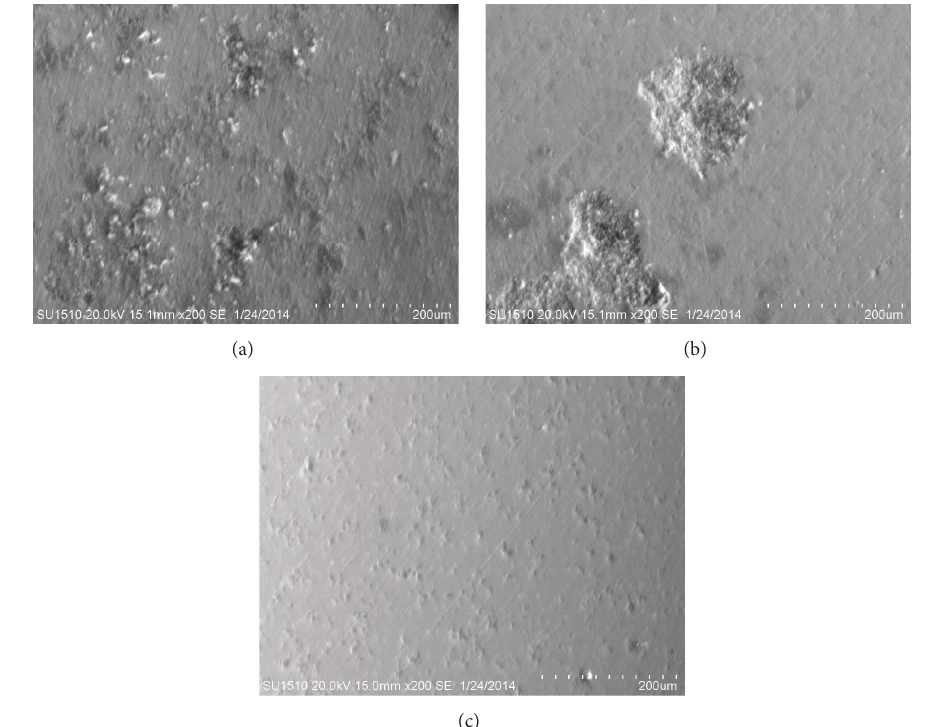
Figure 13: Superficial aspects of Nd magnets after corrosion tests for 24 hours in 3.5% NaCl solution at 25 ∘ C: (a) 35Nd, (b) 40Nd, and (c)